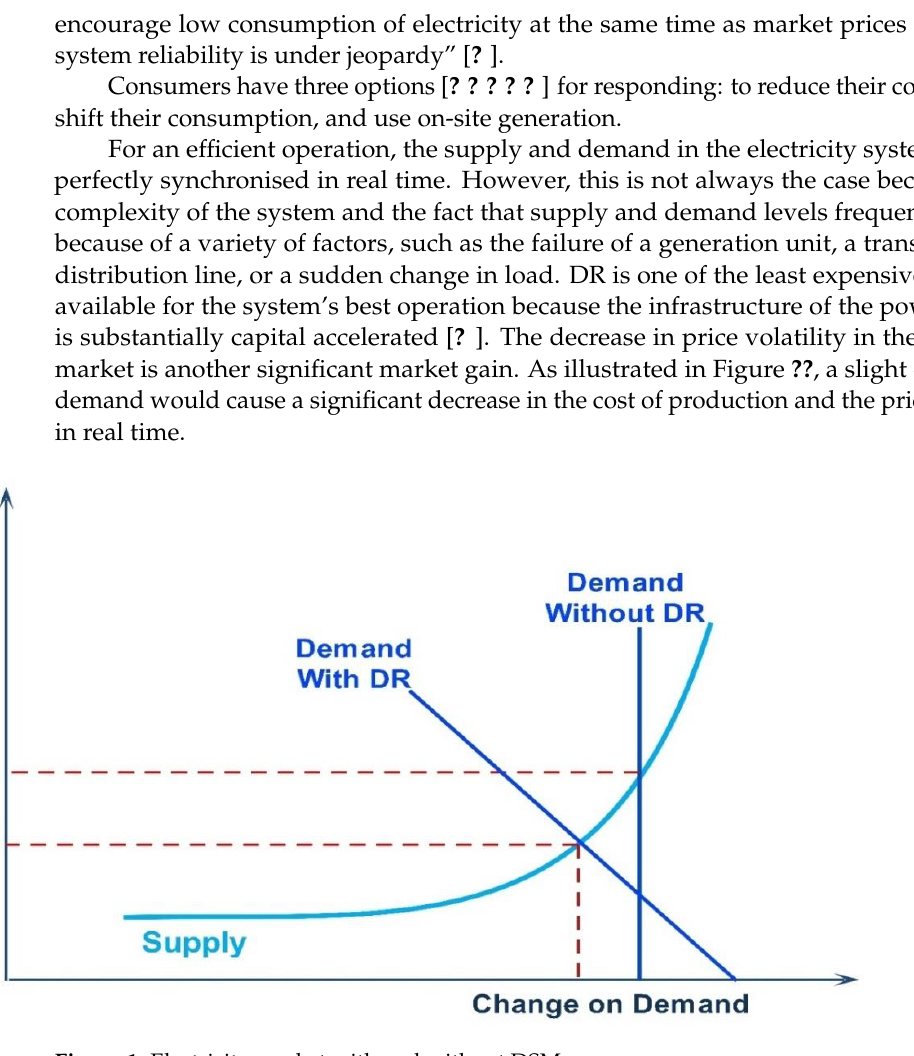
Figure 1. Electricity market with and without DSM.